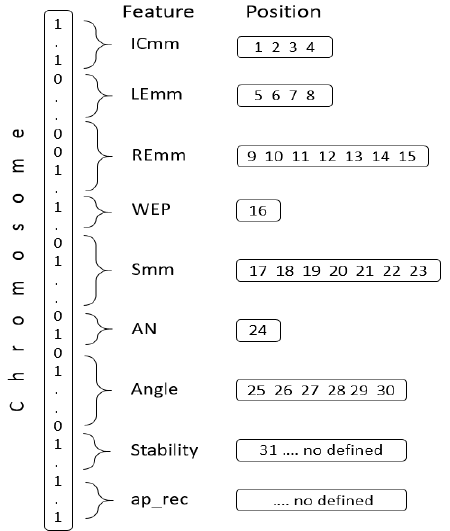
Figure 7. Chromosome structure.